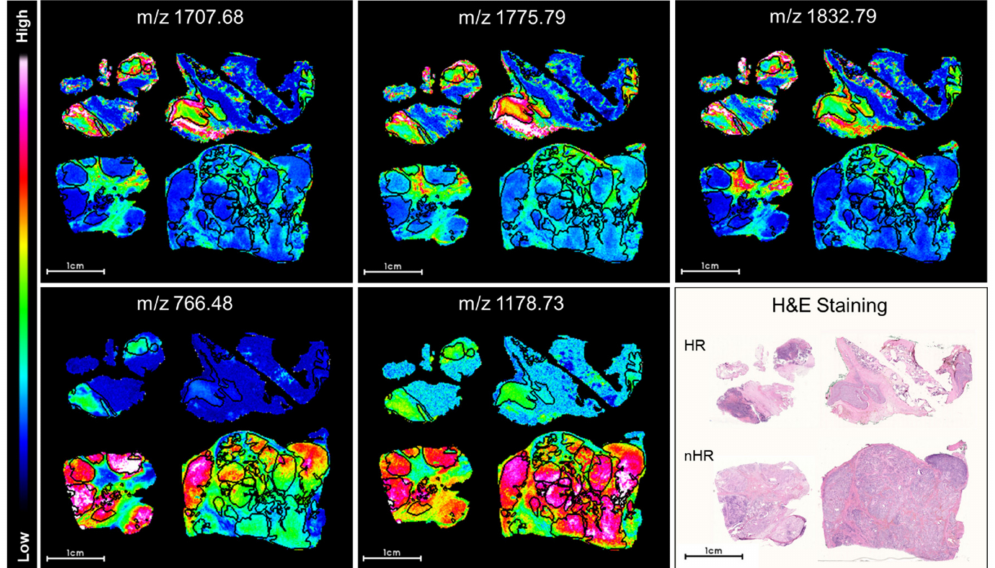
Figure 2. Selected peptides have differential intensity distributions in neuroblastoma cell-rich tumor regions between high and other risk groups. Relative peptide expression (color bar) is shown for MALDI m/z ion peaks with the highest significant area under the curve (AUC) values (>0.85, p < 0.001, top row) in receiver operator characteristic (ROC) analysis and the lowest AUC values (AUC < 0.3, p < 0.001, bottom MALDI images). MALDI-MSI ion images are shown for the same set of neuroblastoma tissue sections categorized either as high (HR) or other risk groups (nHR) in each image. Black lines surround tumor areas with >80% tumor cell content (annotated by the reference pathologist). Hematoxylin and eosin (H&E) staining in sections is shown for